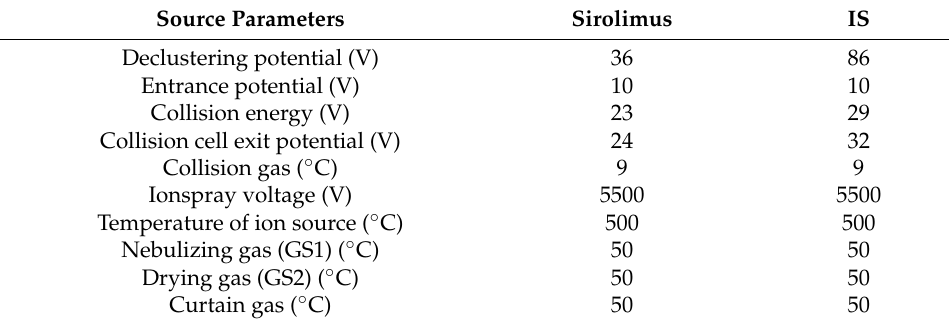
Figure 1. Chemical structures and product ion scan spectra of ( A ) sirolimus and ( B ) ascomycin (IS) in positive ionization mode. Working parameters were similar to those in Table 1, except for declustering potential (130 V), collision energy (50 V), and collision cell exit potential (0 V). Table 1. The LC–MS/MS working parameters.